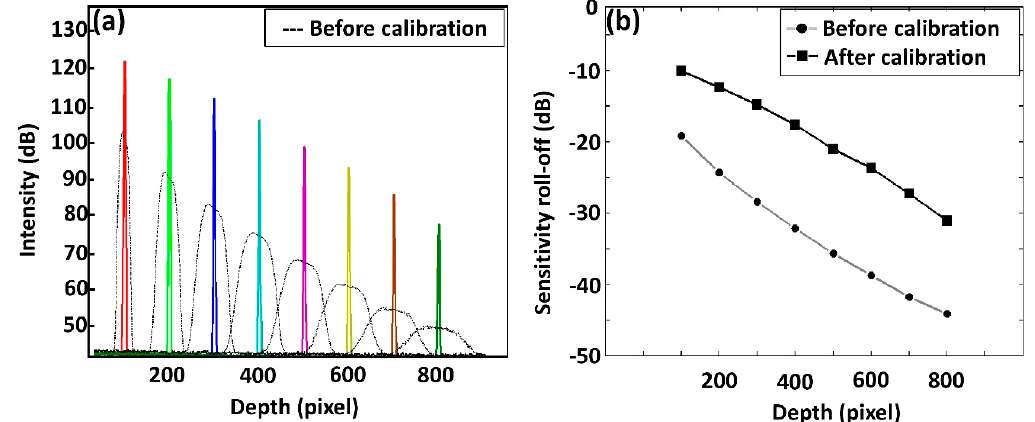
Figure 5. Quantitative representation of system sensitivity assessments. ( a ) Depth-dependent system intensity fall-off and ( b ) depth-dependent sensitivity roll-off (signal-to-noise ratio, SNR) representation. Each PSF peak of Figure 4a corresponds to the correlated pixel numbers of Figure 4b.